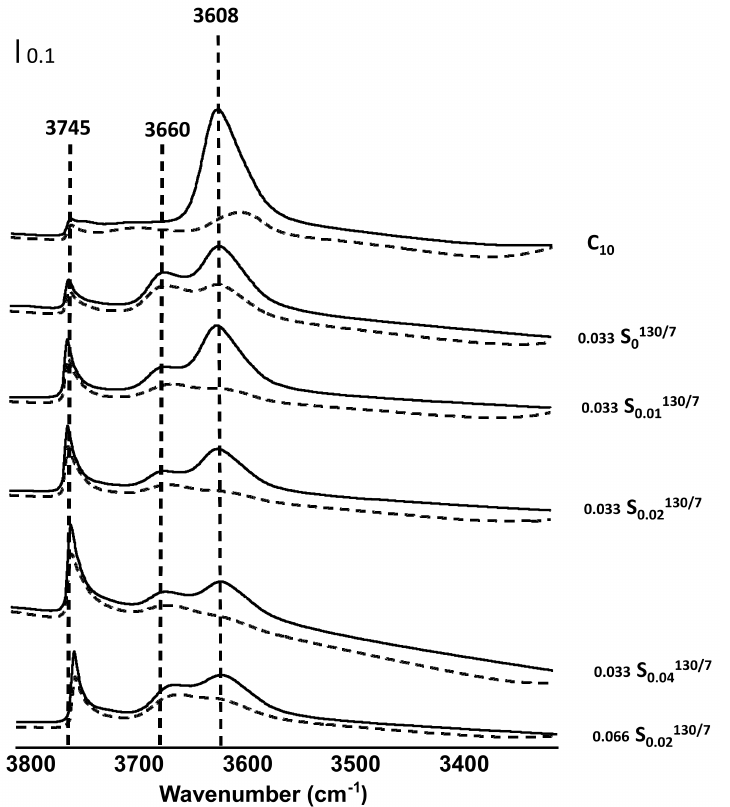
Figure 5. IR Spectra of the synthesized MOR-type zeolites before (full lines) and after (dashed lines) pyridine adsorption at 150 ◦